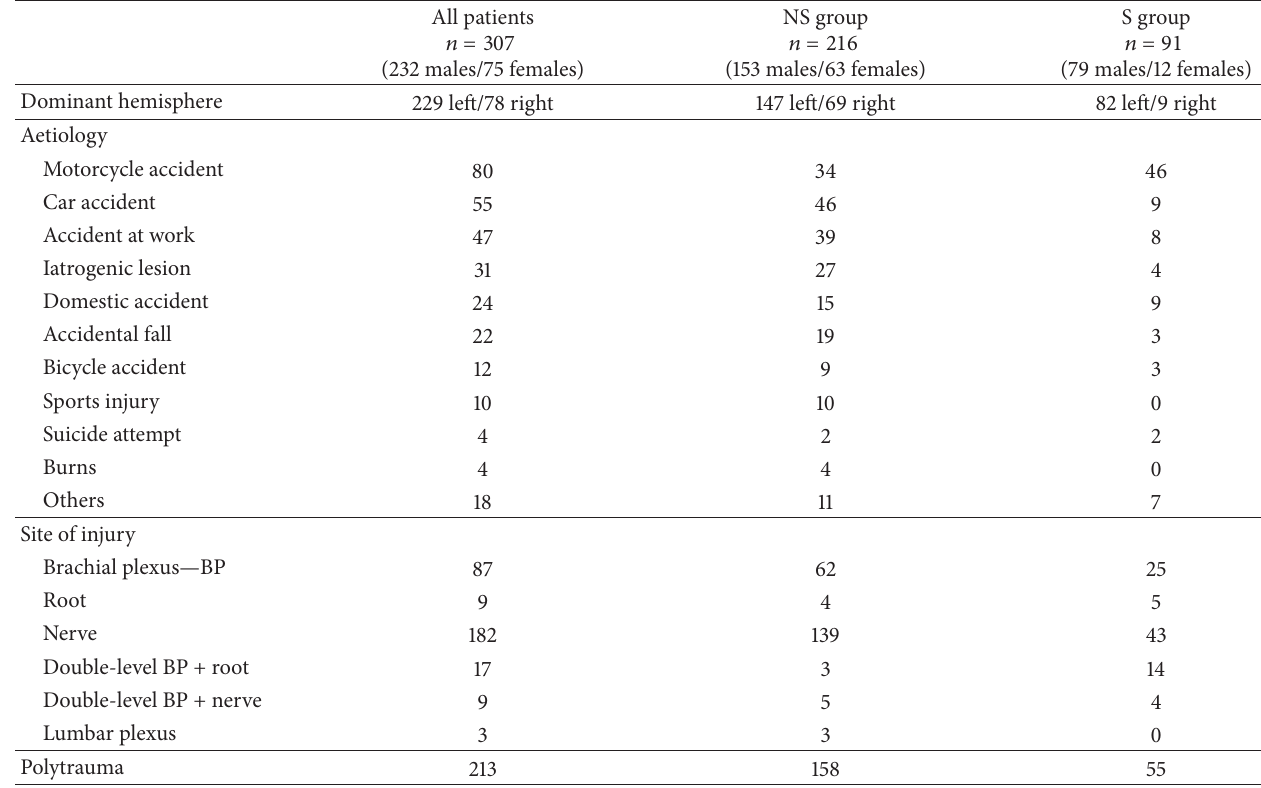
Table 1: TN patients: demographic features, aetiology, mechanism, and site of